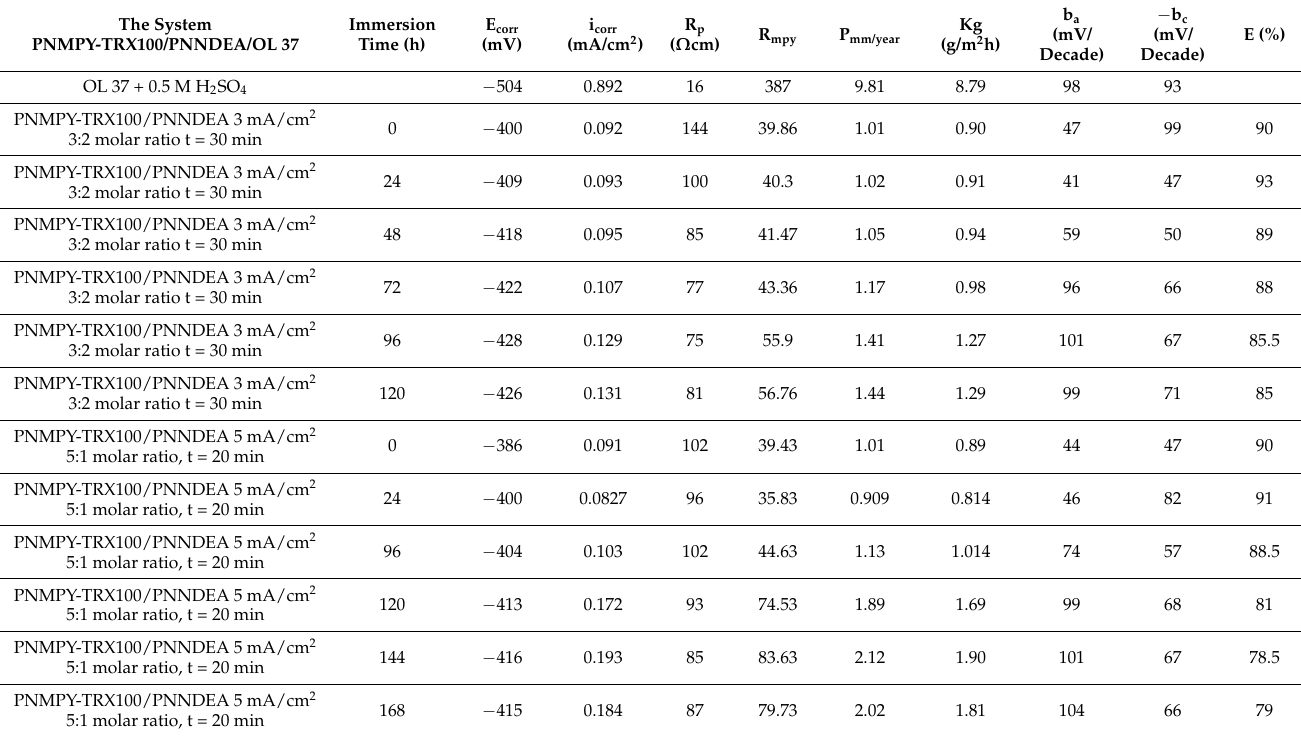
Table 4. Kinetic Corrosion Parameters of Coated and Uncoated OL37 Electrode at Various Immersion Periods in 0.5 M H 2 SO 4 Solutions at 25 ◦